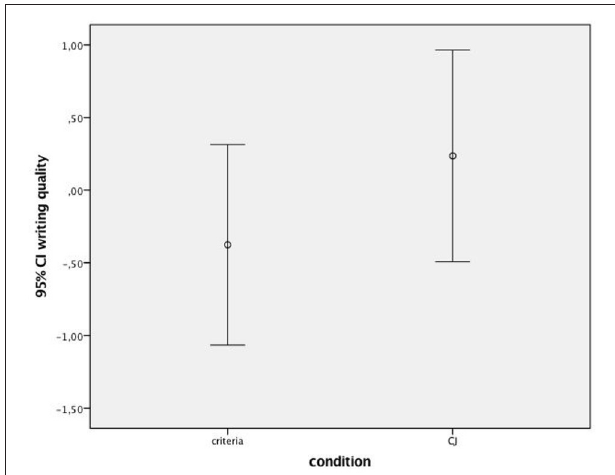
FIGURE 3 | This graph shows the overlap in the 95% Confidence Intervals of the mean scores for writing quality between the criteria and comparative judgment